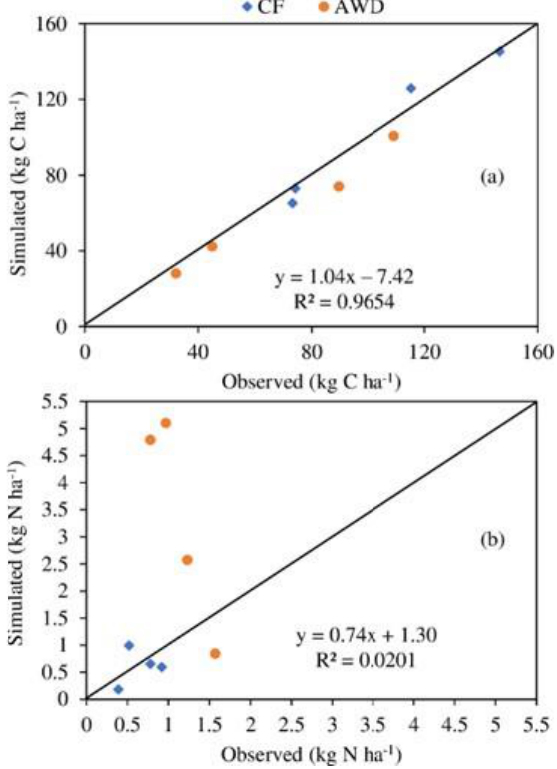
Figure 5. Relationship between observed and simulated cumulative CH 4 ( a ) and N 2 O emissions ( b ). CF — Continuous flooding, AWD — Alternate wetting and drying.